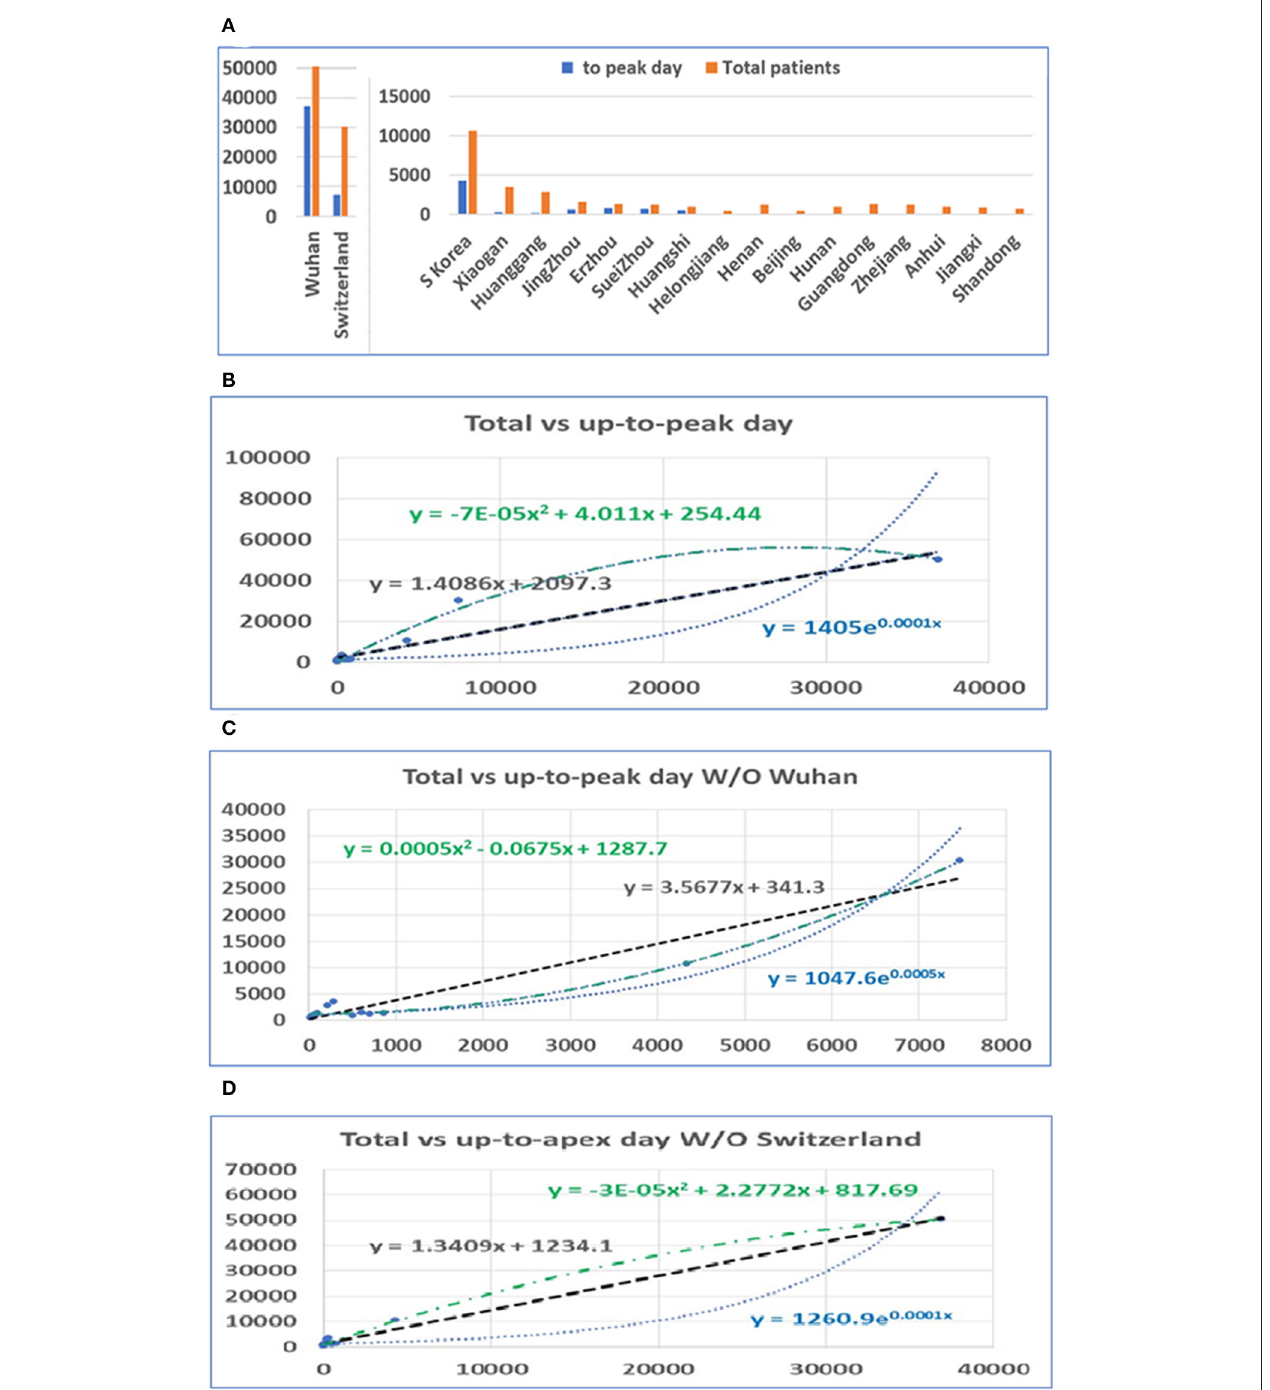
FIGURE 2 | The distribution of patients before and after the pandemic apex. (A) The number of patients in major cities in Hubei Province in China, the provinces with the highest incidence, those in Switzerland, and those in South Korea before and after the apex of the pandemic. (B) The relationship between the total number of patients and the number of patients before the apex of the disease. The number on the vertical axis is the total number of cases, and the horizontal axis is the number of cases before the apex of the pandemic. (C) The relationship between the total number of cases and the number of cases before the apex period, excluding data from Wuhan. (D) The relationship between the total number of cases and the number of cases before the apex period, excluding data from Switzerland.